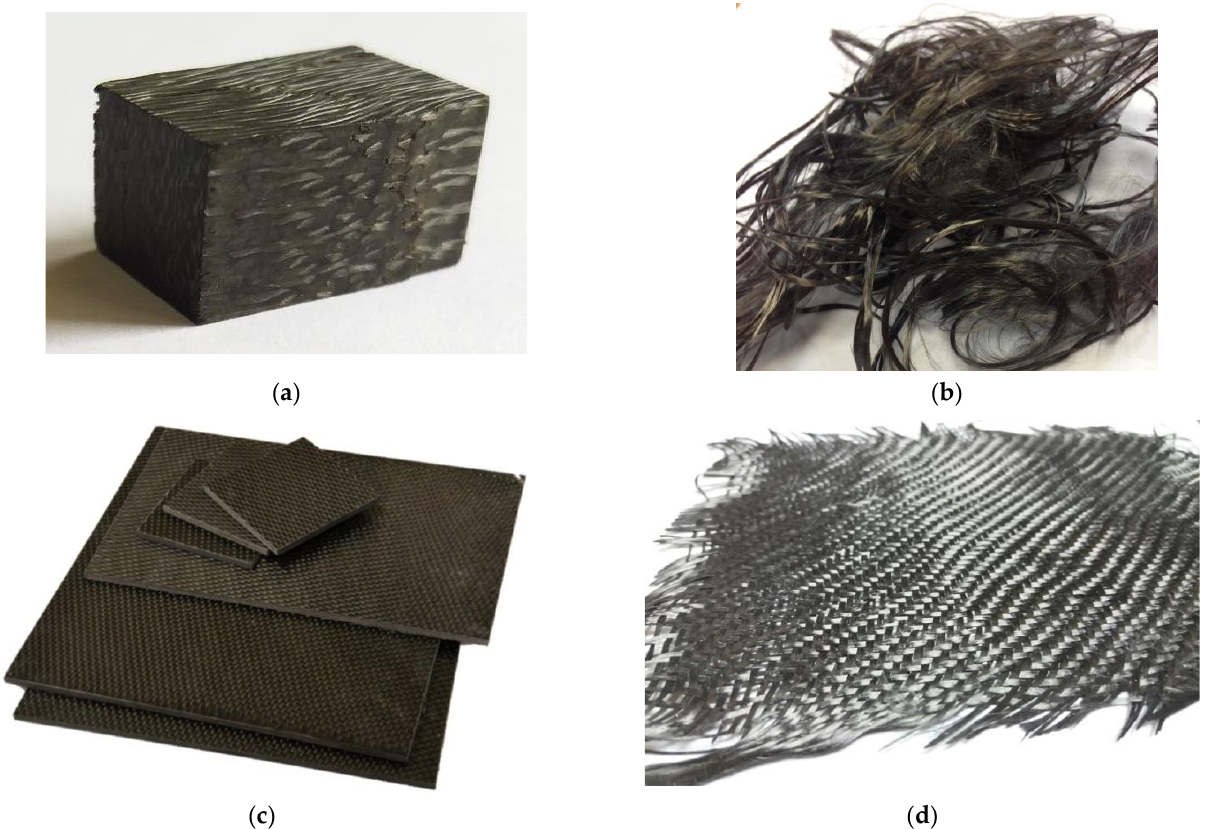
Figure 2. The result of processing CFRP by the solvolysis method: CFRP before the process ( a ) with Ural fabric and ( c ) with Porsher fabric; ( b , d ) recovered fibers after solvolysis at the second stage.